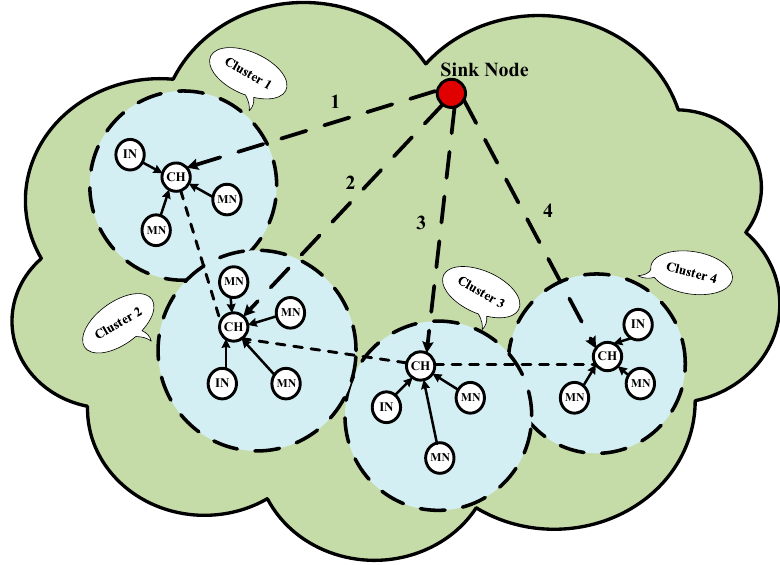
Figure 2. The basic topology of IN mechanism.